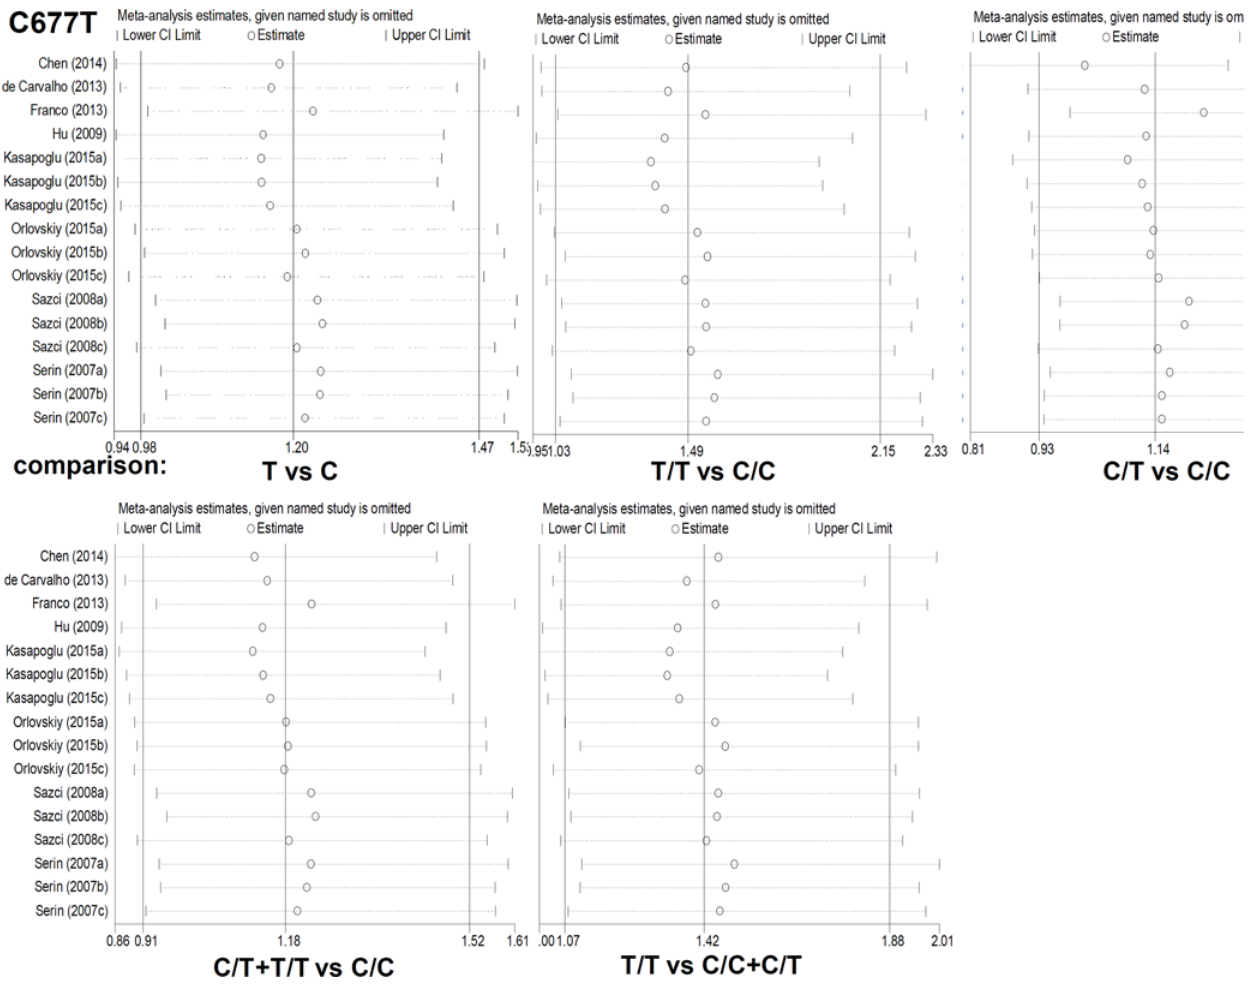
Fig 3. The sensitivity meta-analyses for the association between C677T polymorphism of MTHFR and the risks of